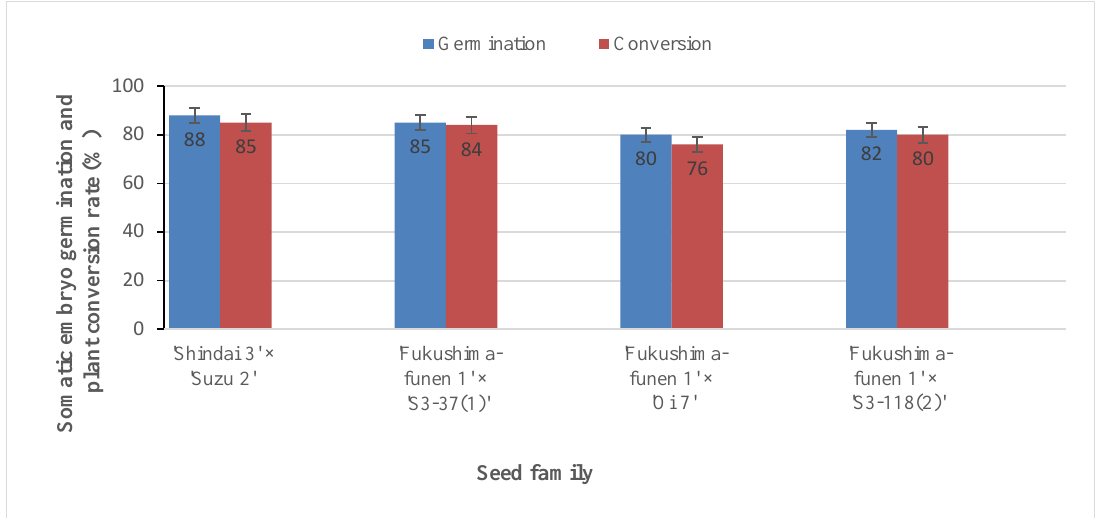
Figure 6. Germination and plant conversion of somatic embryos from sugi seed families carrying the male sterility gene MS1 . Data represent the mean germination and plant conversion rate ± SE of somatic embryos from ten ECLs per seed family. No significant differences in respective percentage values were detected among the seed families according to Tukey’s multiple range test at p < 0.05.